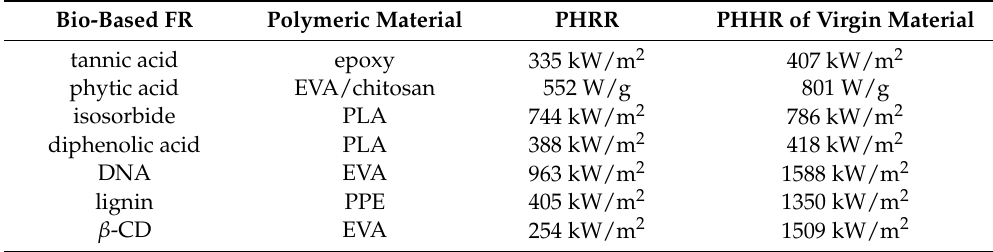
Table 13. Selected examples of bio-based FR, polymeric material treated/prepared, and PHRR values. Bio-Based